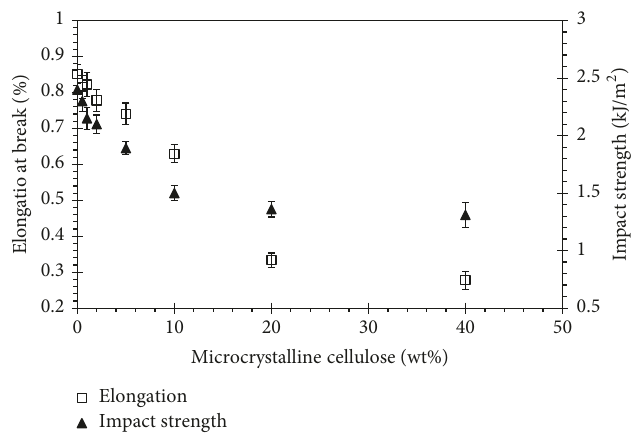
Figure 10: Elongation at break and impact strength of neat PP as a function of MCC wt%.